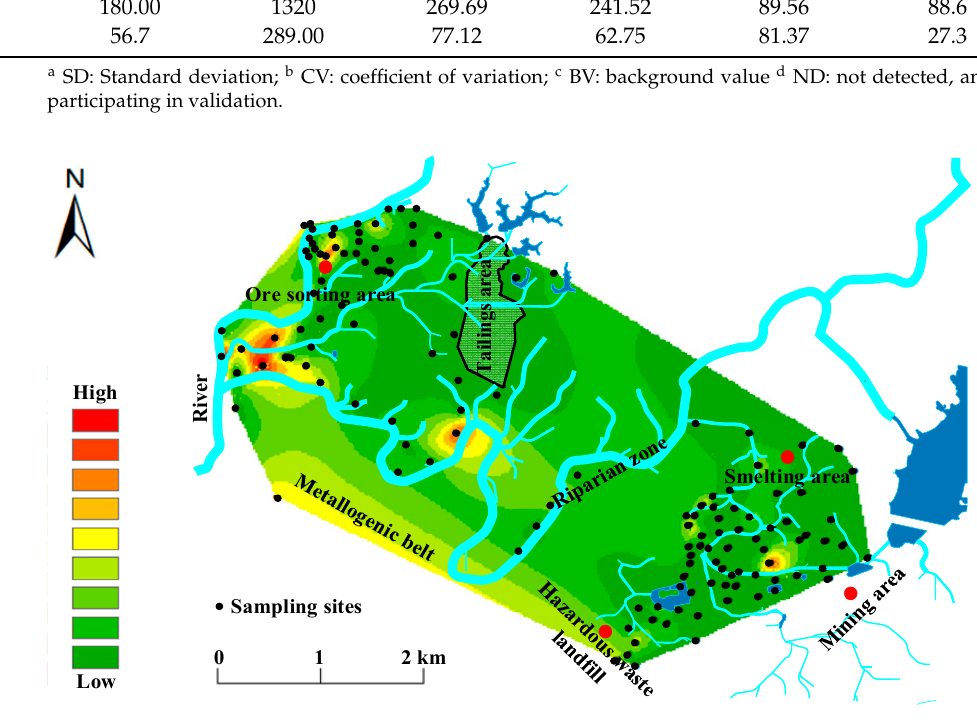
Figure 2. Spatial distribution of cadmium pollution in the soil from an abandoned lead/zinc mine.